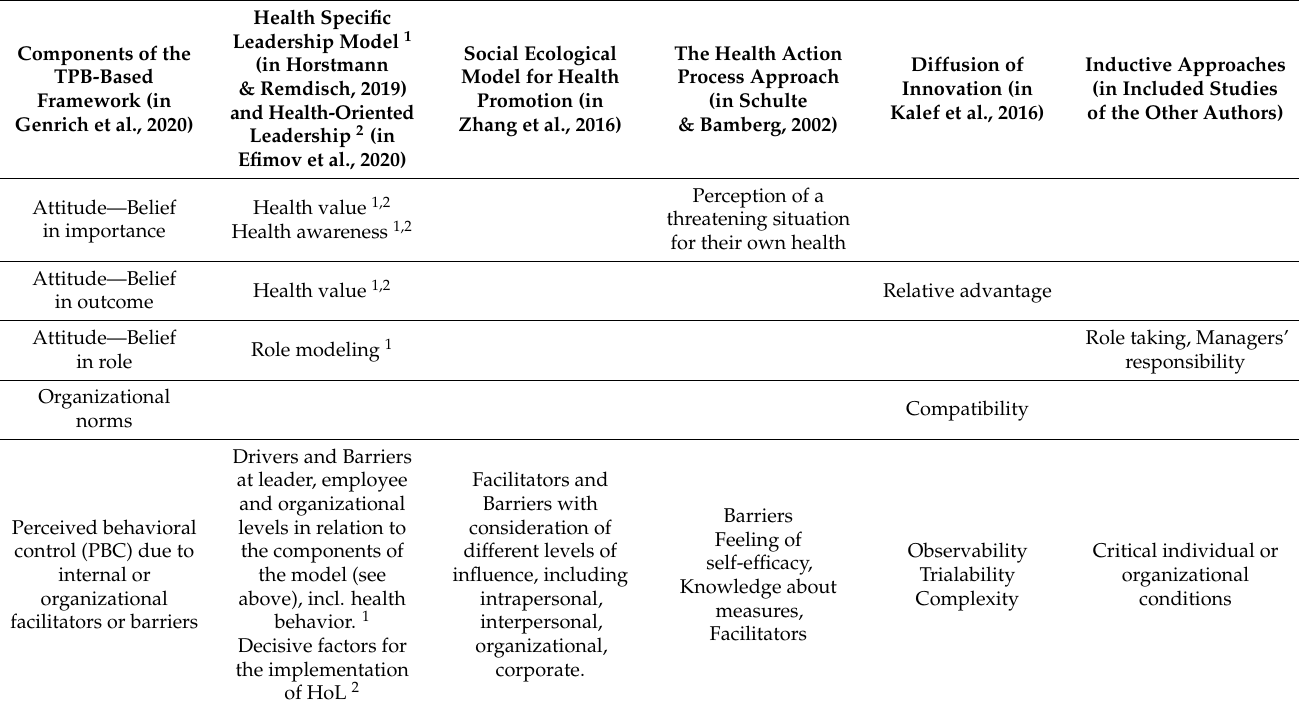
Table 2. Theoretical approaches and their relation to the TPB-based